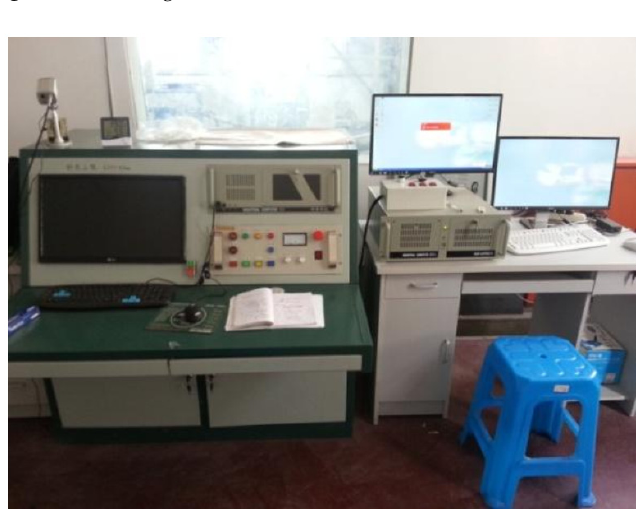
Figure 11. Operational interface.